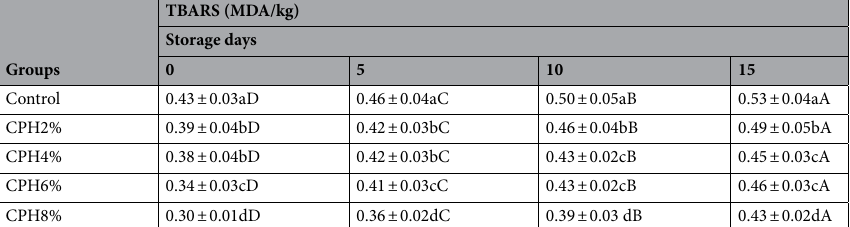
Table 5. TBARS of casein protein hydrolysate (CPH) powder incorporated beef nuggets during storage. CPH: casein protein hydrolysate. All the values are means of triplicate determinations ± Standard Deviation (SD). Means within the column with different small letters are significantly different (p < 0.05) and different capital letters within the row differed significantly.